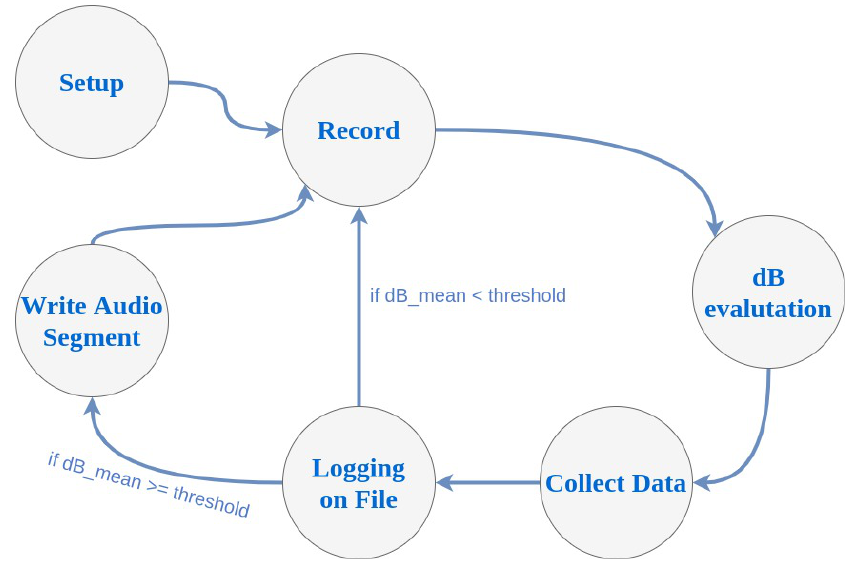
Figure 3. States of